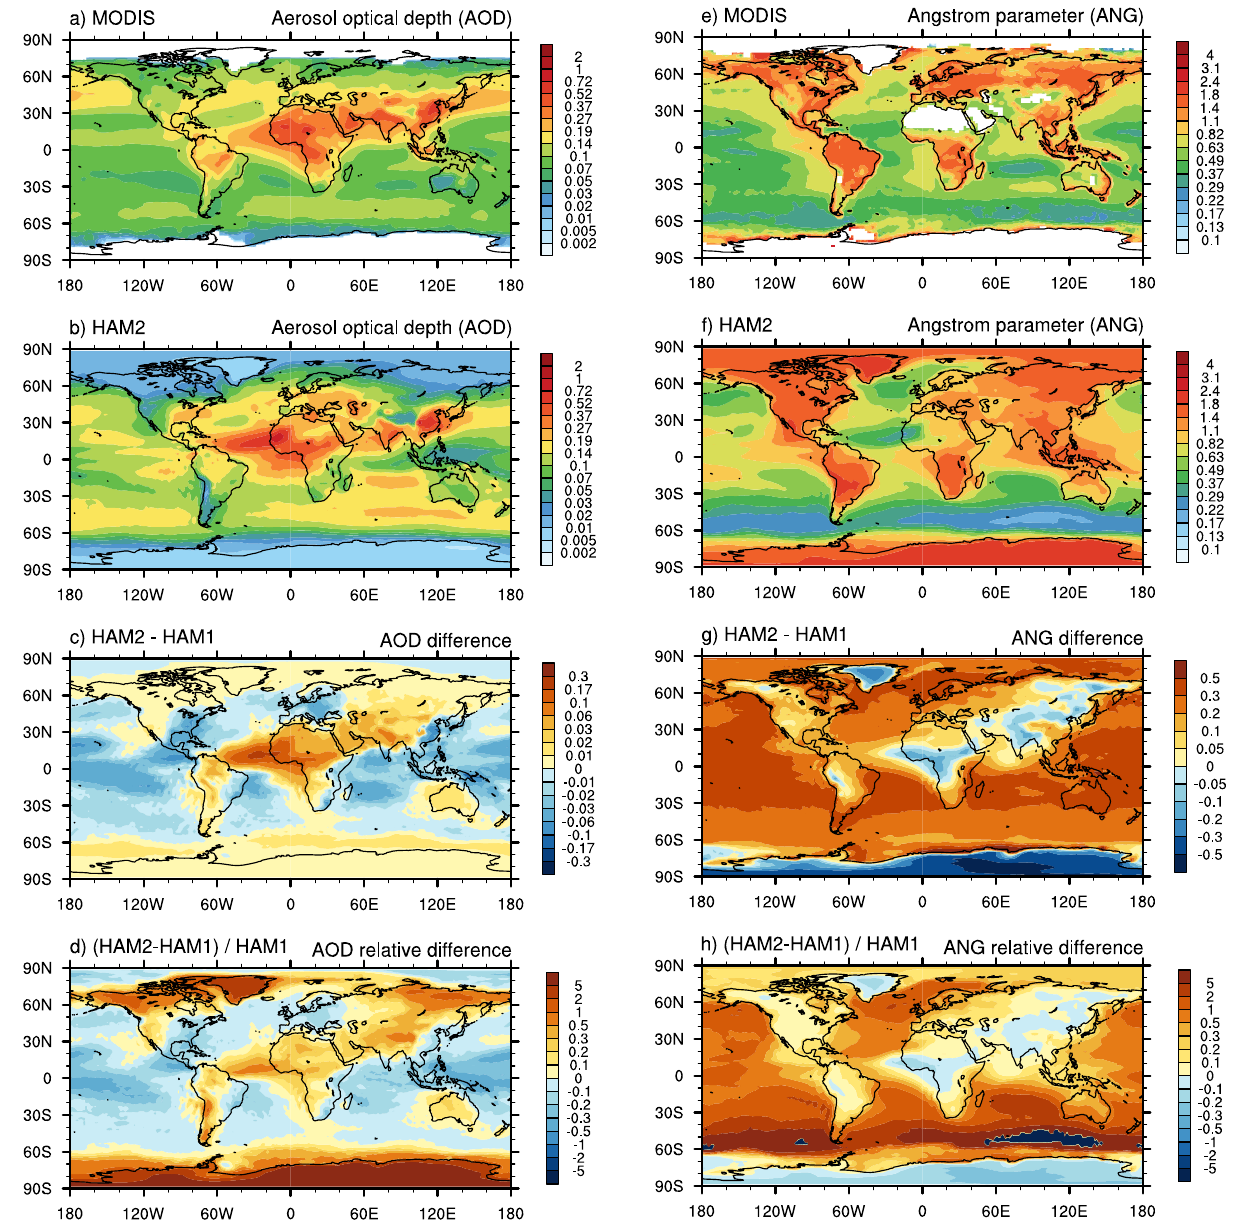
Fig. A1. Geographical distribution of the annual mean aerosol optical depth (AOD, left column) and ˚Angstr¨om parameter (ANG, right column) from the MODIS retrieval (top row), simulated by HAM2 (second row), and the differences between HAM2 and HAM1 results (third and bottom rows). The displayed satellite retrievals are multi-year mean fields. The AOD fields are calculated/retrieved at the mid- visible wavelength 0.55µm. The MODIS ˚Angstr¨om parameter is retrieved using the wavelengths 0.55µm and 0.865µm over the ocean, and 0.47µm and 0.66µm over land. The model-simulated ANG is calculated using the wavelengths 0.55µm and 0.825µm at all grid